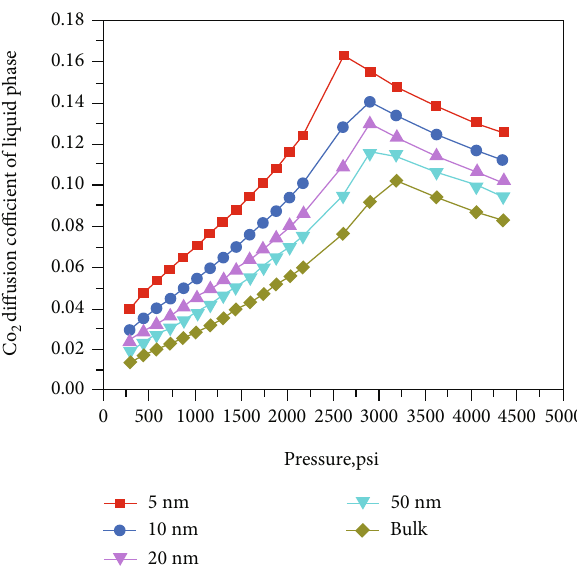
Figure 20: CO di ff usion coe ffi cient of liquid phase for Bakken 2 tight oil versus pressure at various pore radii at T = 230 ° F.